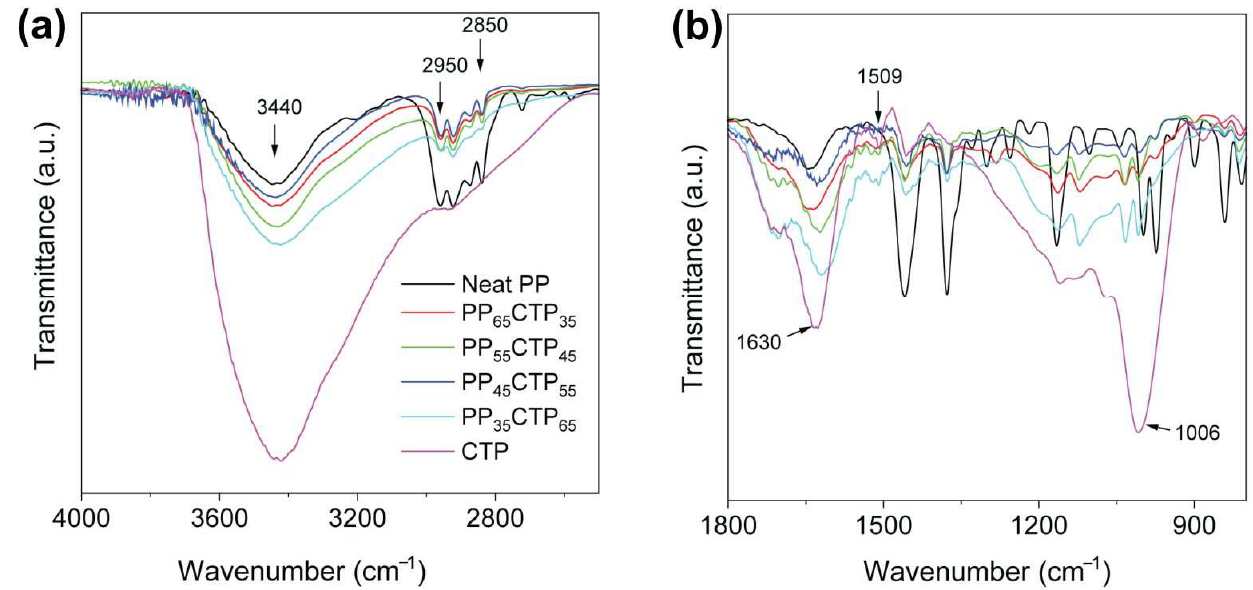
Figure 1. Infrared spectra for the PP − CTP composites and their single phases ranging from ( a ) 4000 to 2400 cm − 1 and from ( b ) 1800 to 800 cm − 1 .